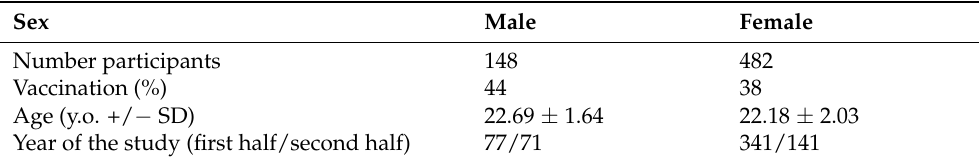
Table 2. Characteristics of students